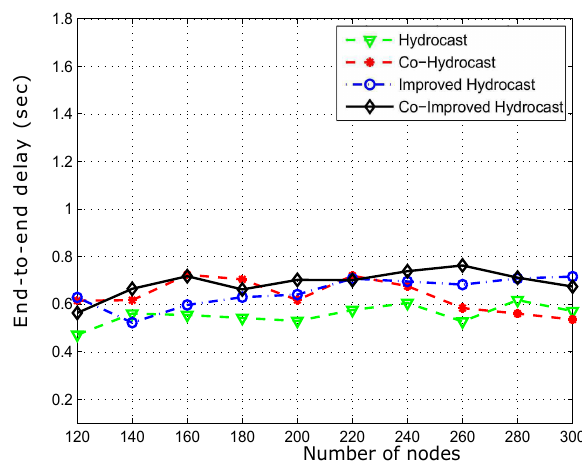
Figure 18. Average propagation delay between source and destination.